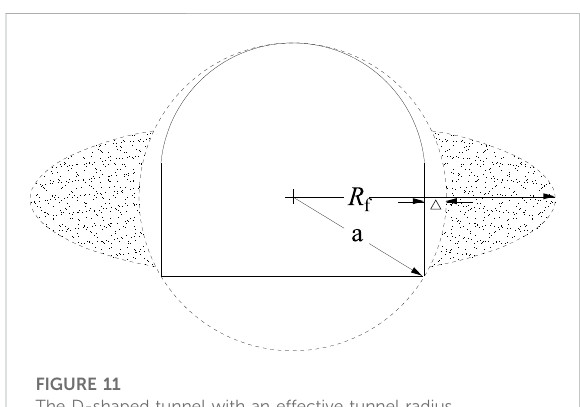
FIGURE 11 The D-shaped tunnel with an effective tunnel radius.